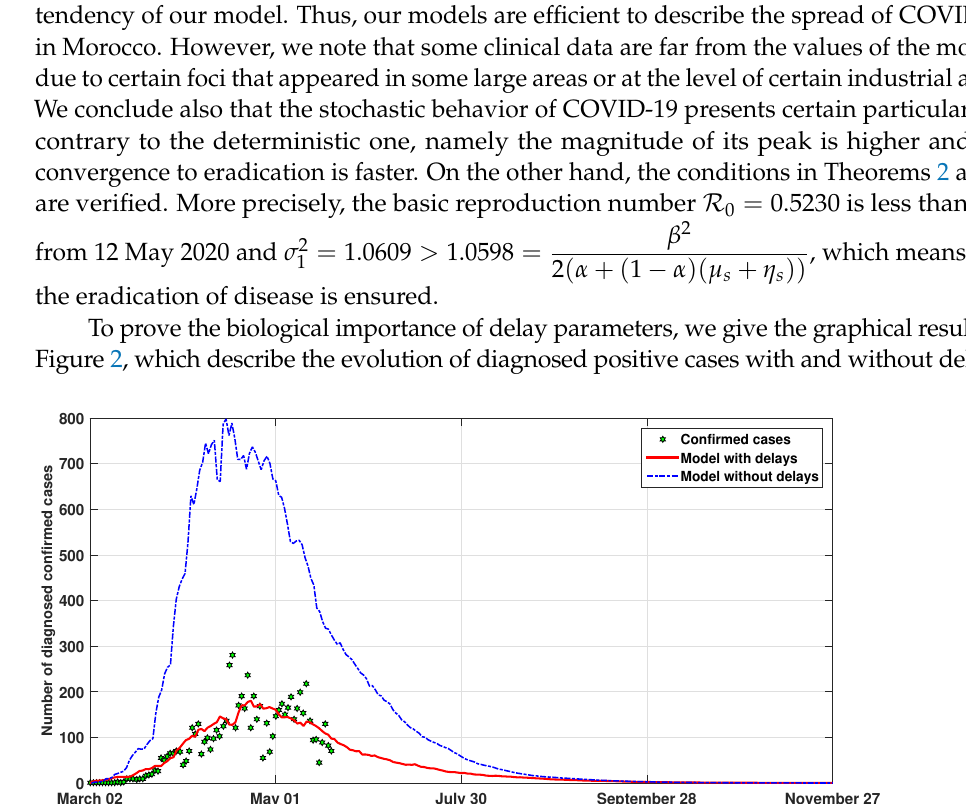
reported cases of COVID-19 in Morocco.